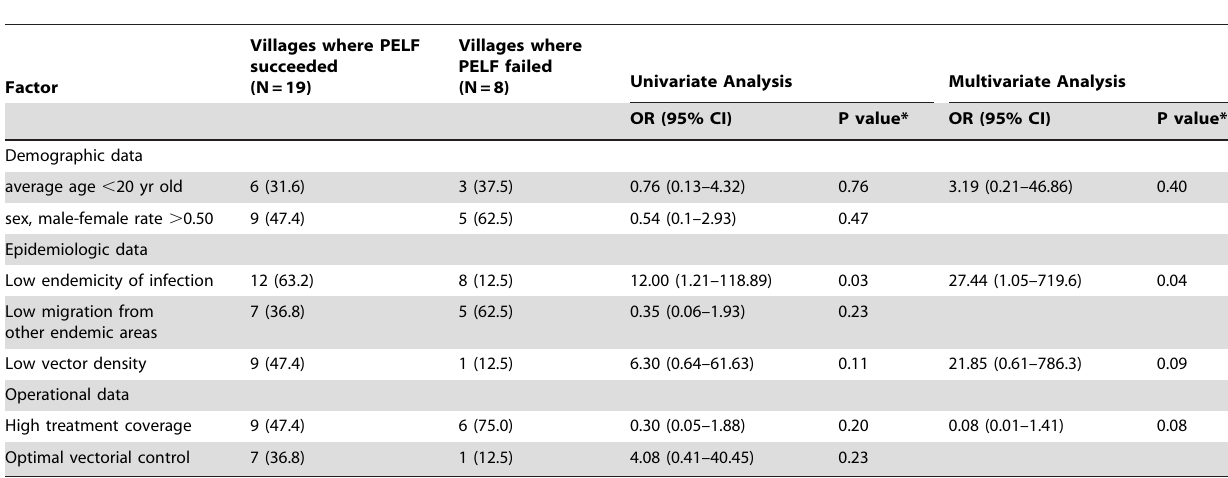
Table 3. Association between characteristics of villages and program related factors and PELF success to stop transmission.